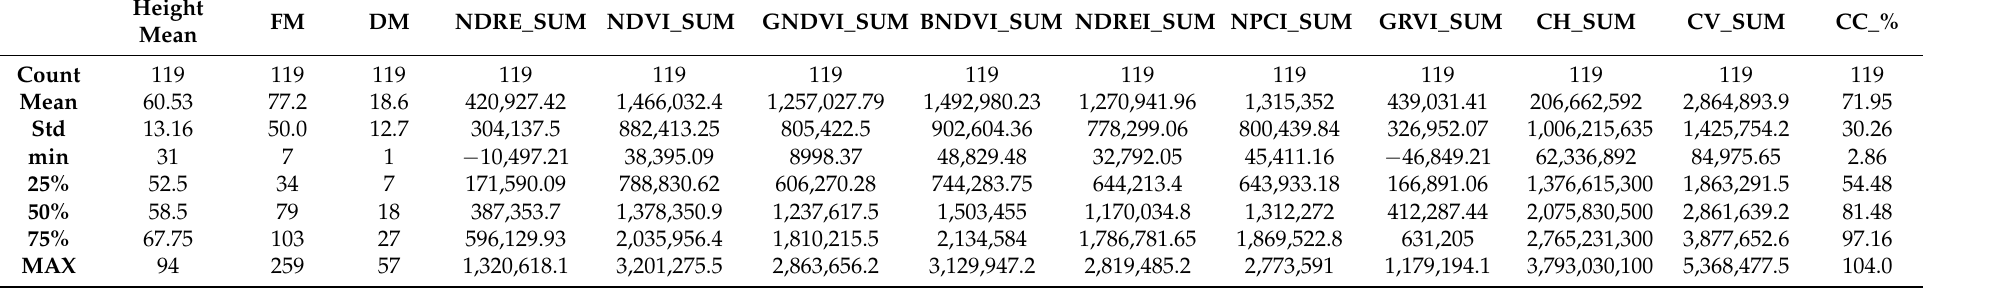
Table 6. EDA built with GTD and UAV remote